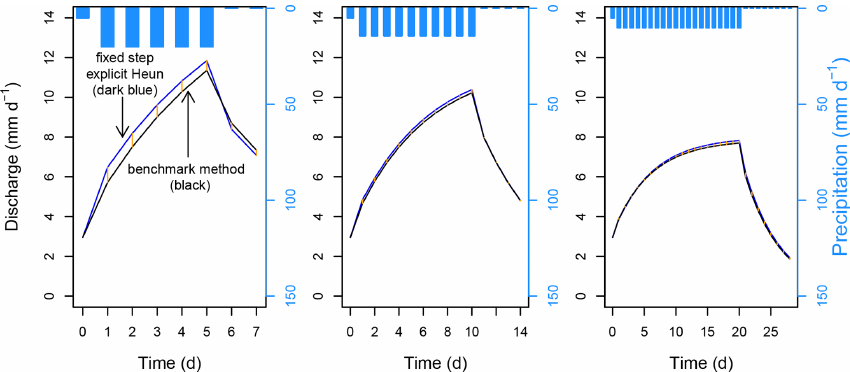
Figure 4. Example hyetographs and discharge hydrographs, including results from the fixed step explicit Heun method and the benchmark method for 5, 10, and 20d precipitation events. The vertical orange lines are the differences between the two hydrographs and represent the numerical error. From the shortest to the longest duration, the RMSEs are 0.55, 0.14, and 0.10mmd − 1 . The precipitation forcing data come from the IDF curve scaled at 2.5% of the historical maxima interpolation. These hydrographs all result from the same structure (FUSE 092), the same parameter set, and the same spin-up precipitation intensity (5mmd − 1 ). The last day of the spin-up period is shown.